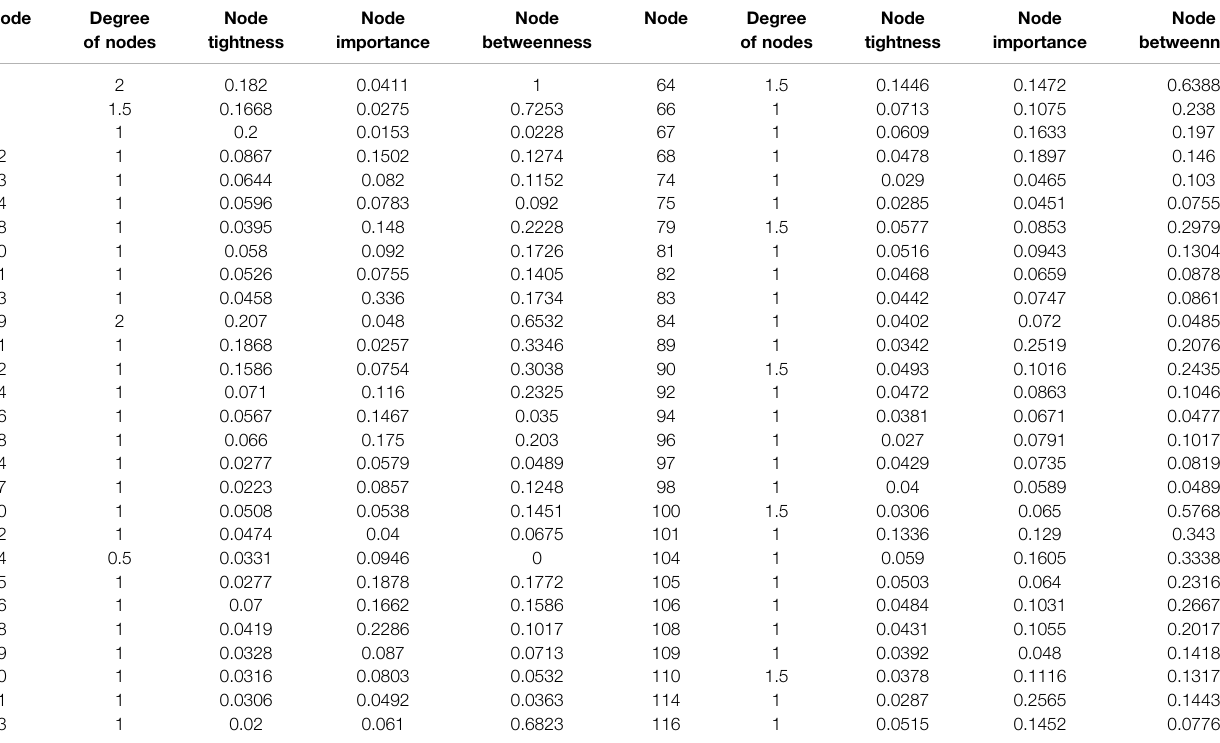
TABLE 4 | Indicator assessment